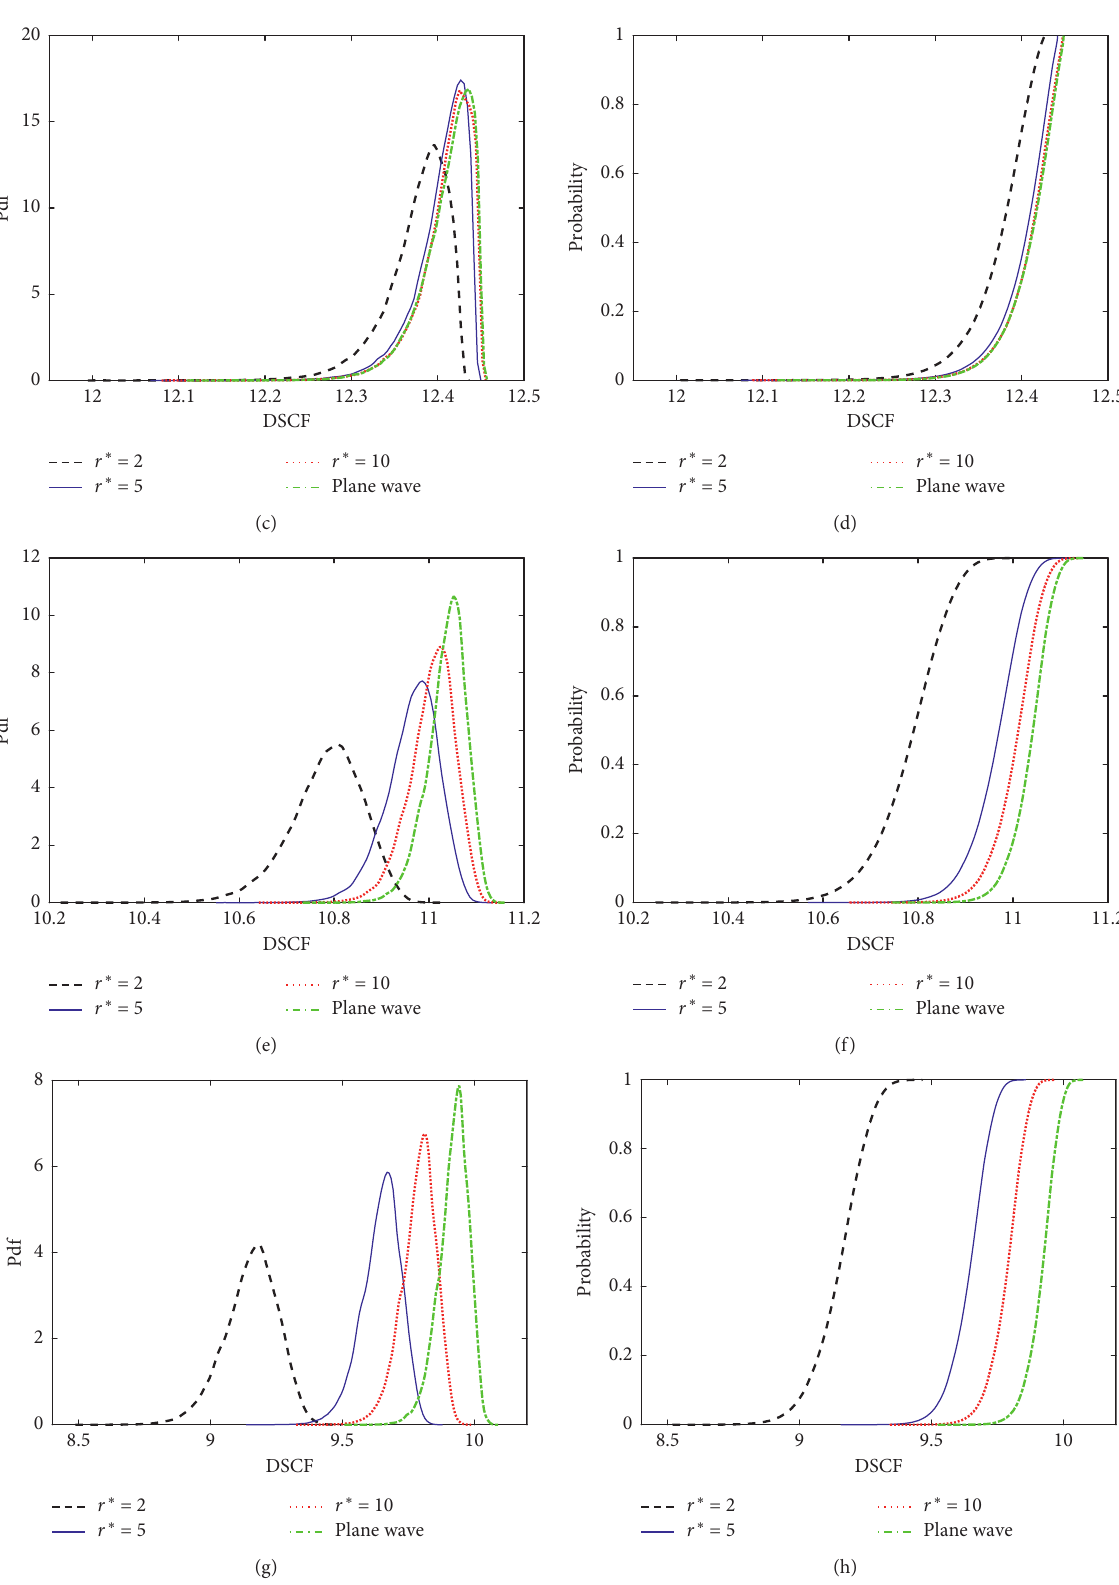
� 0.1: (a) PDF f � 10Hz; (b) CDF f � 10Hz; (c) PDF f � 50Hz; (d) CDF G